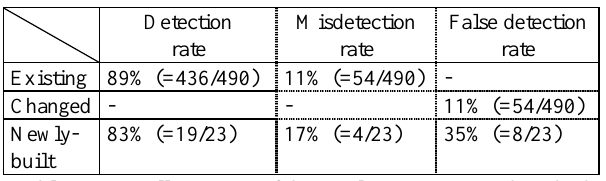
Table 2. Overall accuracy of the result using proposed method